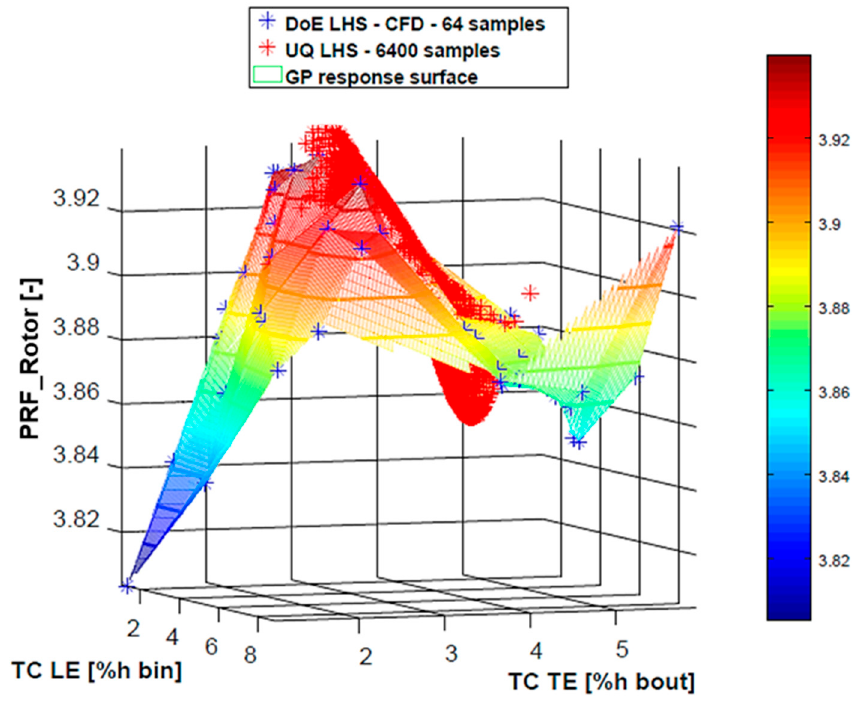
Figure 9. SB-UQ: rotor pressure ratio response surface and samples.